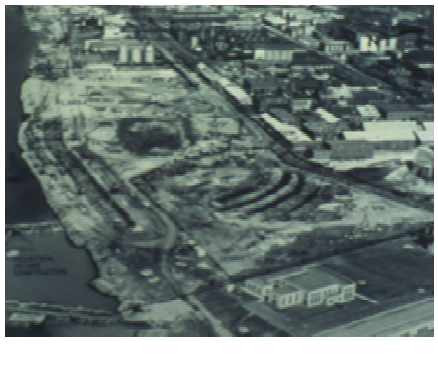
Figure 1. Example of historical aerial photo documentation of structural changes at a hazardous waste site. Shoreline is filled and expanded outward between 1950 (a) and 1958 (b) . An industrial facility including several large petroleum tanks has been established by 1964 (c) . Historical aerial photos, routinely acquired for other purposes easily captures morphological changes on the landscape that reveal import details about hazardous waste facilities. Source: the EPA/Environmental Photographic Interpretation Center